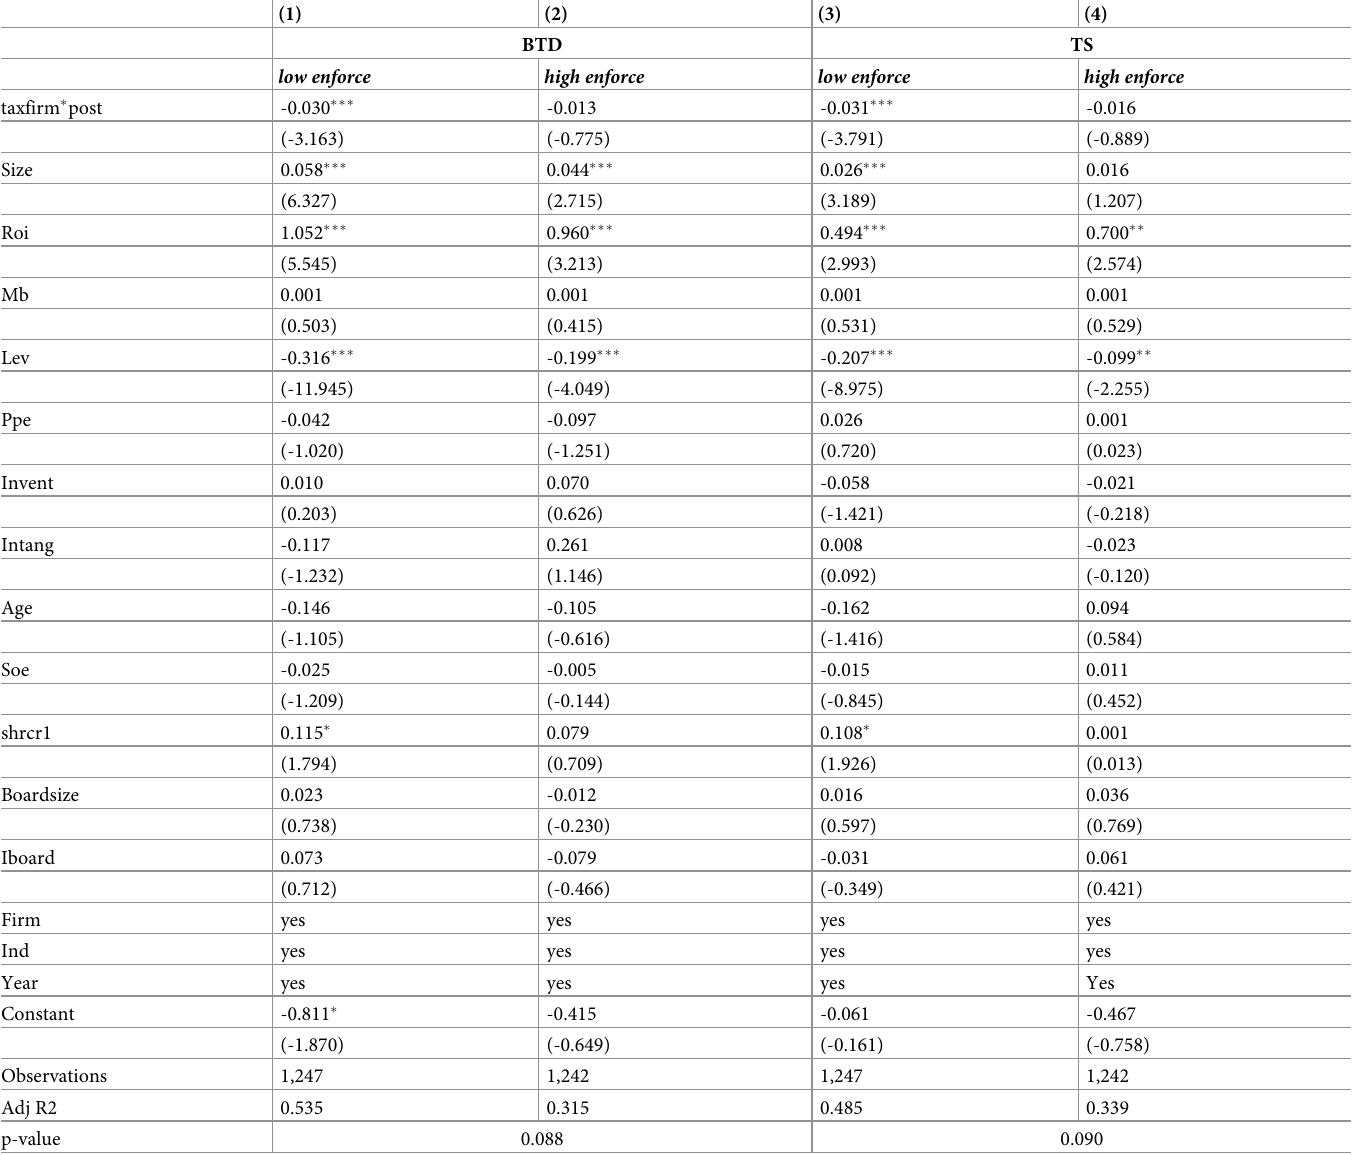
Table 15. The intensity of tax collection and